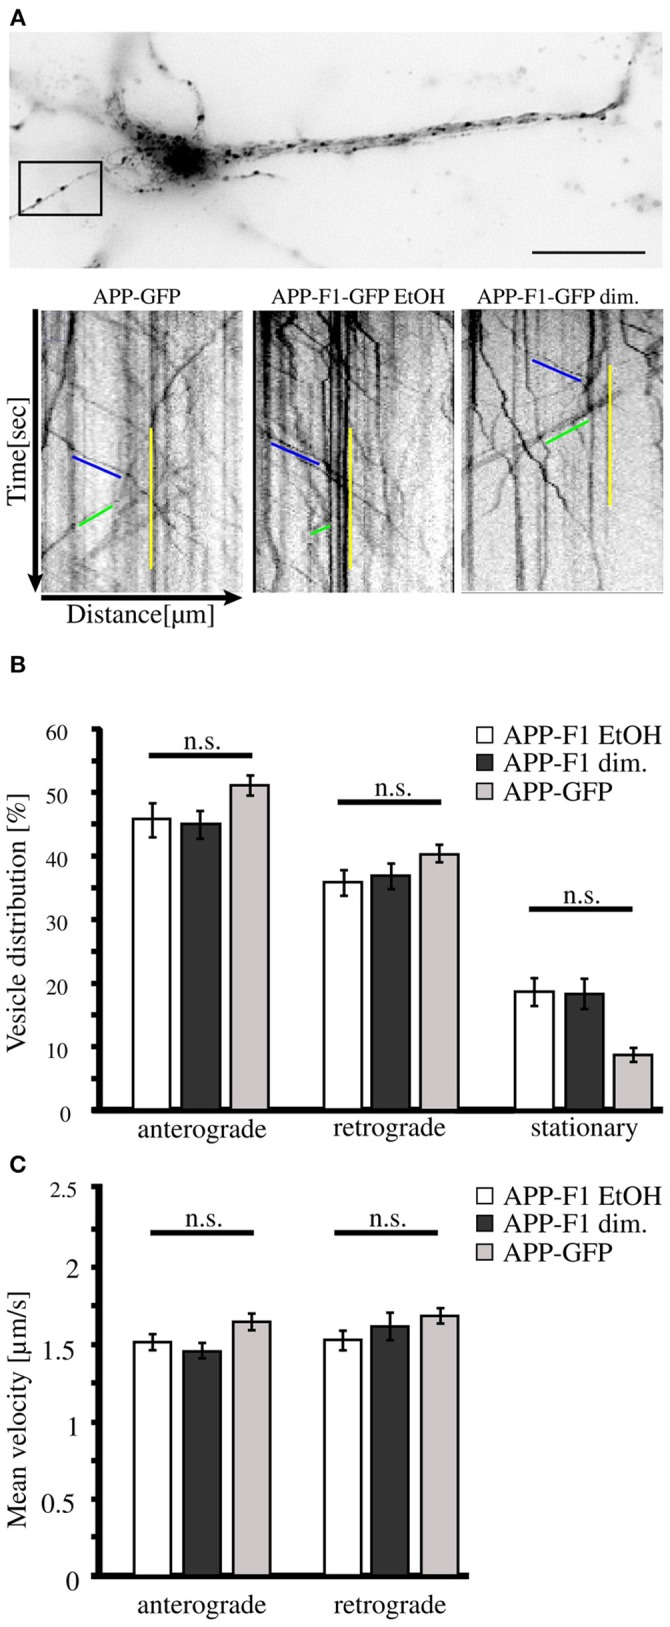
APP dimerization does not affect its transport characteristics. Murine cortical primary neurons (DIV 6) were transiently transfected with expression constructs encoding APP-GFP or APP-F1-GFP. After 18–20 h and 1 h prior live cell recording of axonal vesicle movements, APP-F1-GFP expressing neurons were either treated with 100 nM AP20187 (dimerizer) or for control with the vehicle of the dimerizer, ethanol (negative control). (A) Representative primary neuron and kymographs of cells expressing APP GFP or APP-F1-GFP treated with dimerizer or ethanol respectively. The ROI is marked by a rectangle. Bar: 20 μm. (B) Vesicle distribution and (C) anterograde and retrograde transport velocities of APP-GFP, non-dimerized APP-F1-GFP (ethanol control) and APP-F1-GFP dimerized vesicles. No differences among APP variants could be observed (one-way ANOVA followed by Bonferroni post hoc test). Bars represent mean values ± SEM, n = 3 (≥16 cells per approach).